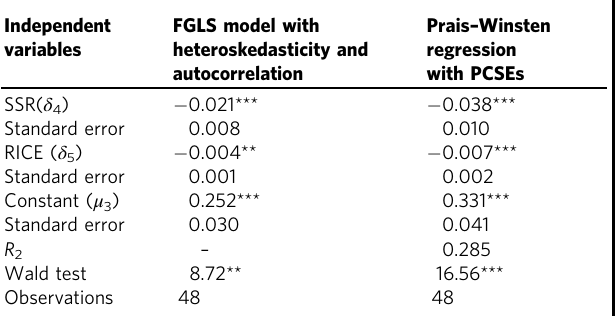
Table 13 Estimation results of model 3 in panel data analysis.